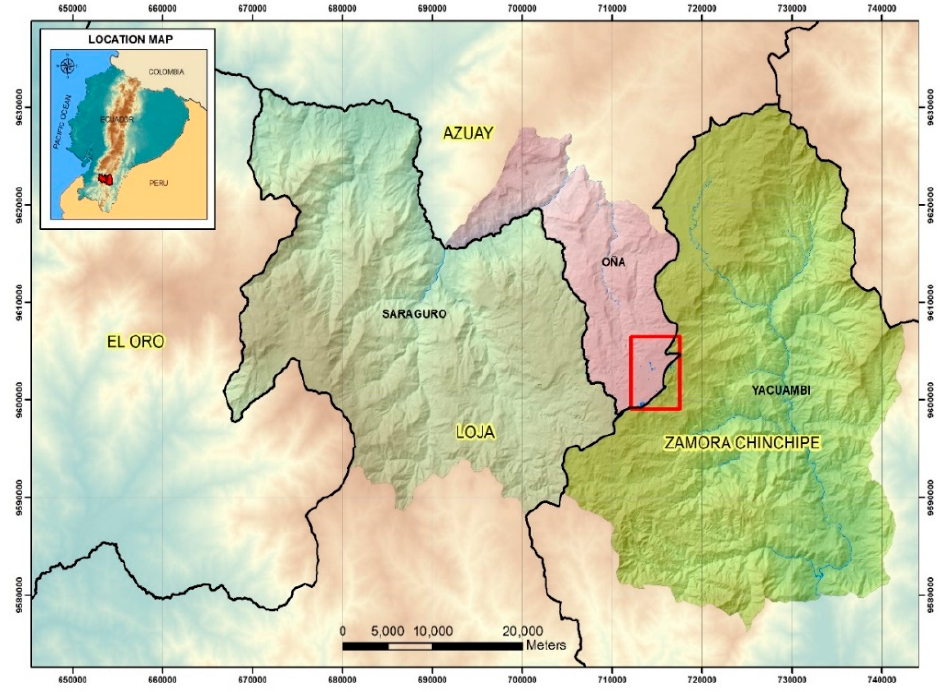
Figure 1. Location of the Tres Lagunas lake system in Southern Ecuadorian Andes around 3300 m.a.s.l.